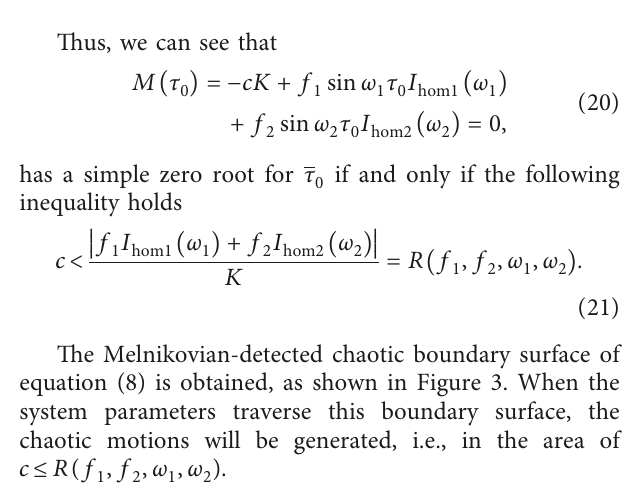
Figure 3: The boundary surface of chaotic